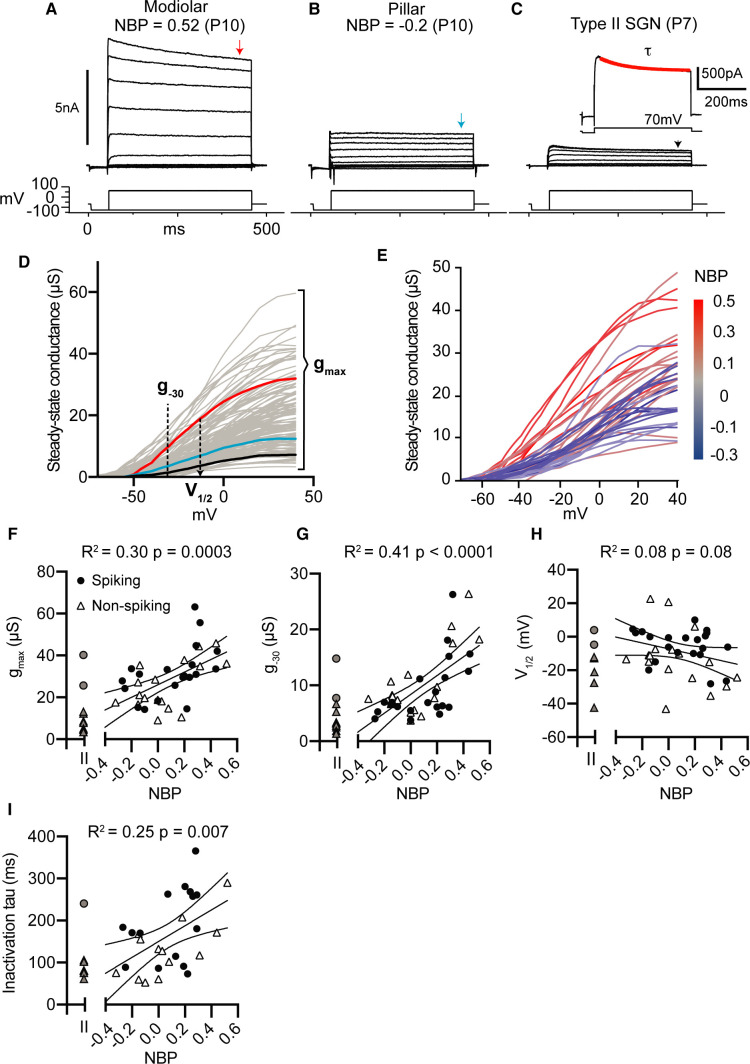
Net whole-cell conductances increase as SGN synaptic position moves from pillar to modiolar-face of the inner hair cell.(A–C) Voltage-clamp responses of a modiolar-contacting (A), pillar-contacting type I (B), and a type II SGN (C). For each cell, we held the potential at −60 mV, followed by a series of voltage 400 ms steps from −120 mV to 70 mV, and then finally back to the holding potential. For each cell, we measured current-voltage relationships at approximate steady-state (400 ms indicated by the arrow). We measured the time course for outward current inactivation by fitting a single exponential curve to the current evoked by a +70 mV voltage step (inset). (D) Steady-state conductance in microSiemens as a function of command voltage of all SGN recorded with three measurements: the magnitude of conductance at −30 mV (g-30), the maximum conductance (gmax), and the half-activation potential (V1/2) via Boltzmann function. (E) Steady-state conductances of identified type I SGN as a function of normalized basal position. (F–I) Voltage clamp properties as a function of normalized basal position (NBP) (Spiking, black dot; non-spiking, triangle). Linear regression models were fitted to each parameter with statistical significance test of p<0.05. All parameters were significant except for V1/2.Figure 4—source data 1.Voltage-clamp features versus normalized basal position for Figure 4F through 4I.Conductance values are shown in units of micro Siemens.